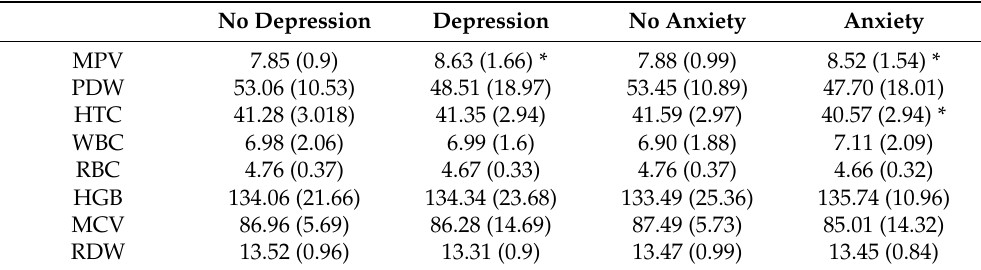
Table 2. Complete blood parameters in the study groups. Variables are summarised as mean (standard deviation). No Depression Depression No Anxiety Anxiety MPV 7.85 (0.9) 8.63 (1.66) * 8.52 (1.54) * PDW 53.06 (10.53) 48.51 (18.97) 53.45 (10.89) 47.70 (18.01) HTC 41.28 (3.018) WBC